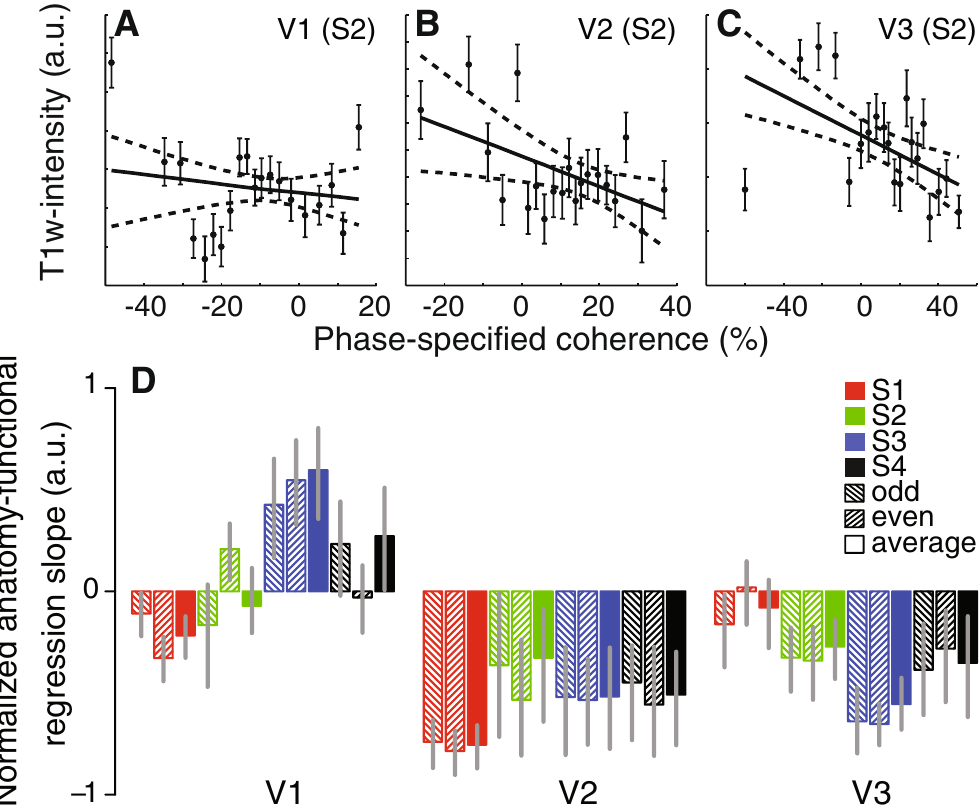
Figure 4. Relation between anatomical and functional variations of V2 and V3 stripe-based subdivisions. The relationship between functional and anatomical variations for subject S2 in V1, V2 and V3 are shown in panels A–C respectively. The solid and dashed lines indicate the linear relationship and 95% confidence interval obtained by bootstrapping the phase-specified coherence quantiles. The normalized slope between functional and anatomical data for all subjects and independent halves of the data are shown in panel D. All error bars reflect the 95% confidence intervals. We observed a significant relationship between T1w intensity and fMRI response in each subject, except S1 V3, providing converging evidence for the V2 and V3 stripe-based subdivisions. We propose that the V2 and V3 subdivisions that respond more to faster temporal frequencies are more